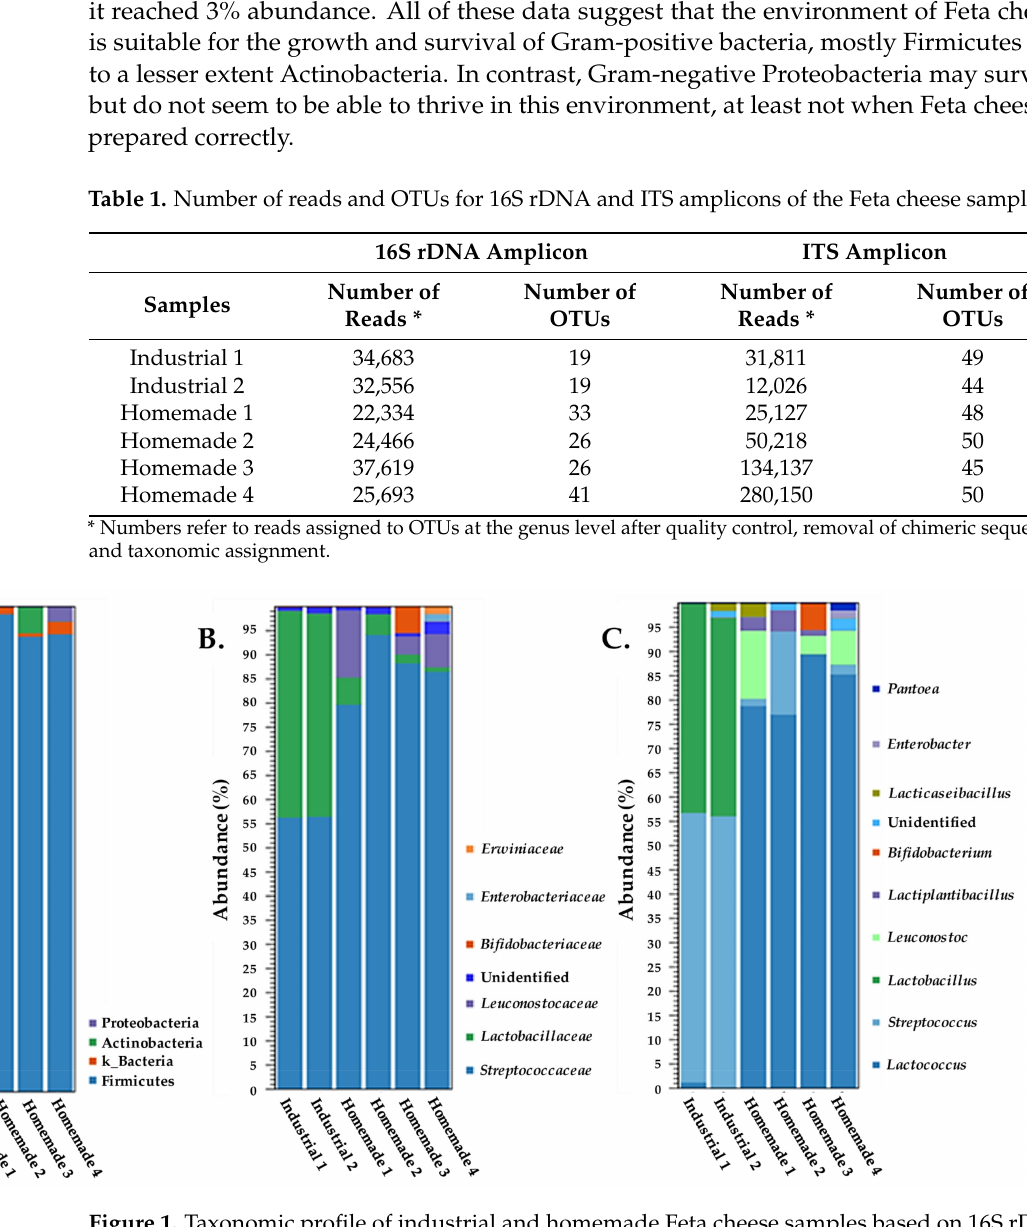
Figure 1. Taxonomic profile of industrial and homemade Feta cheese samples based on 16S rDNA amplicon data. Taxa were clustered at the phylum ( A ), family ( B ), and genus ( C ) levels. Panel ( C ) presents genera with abundance ≥